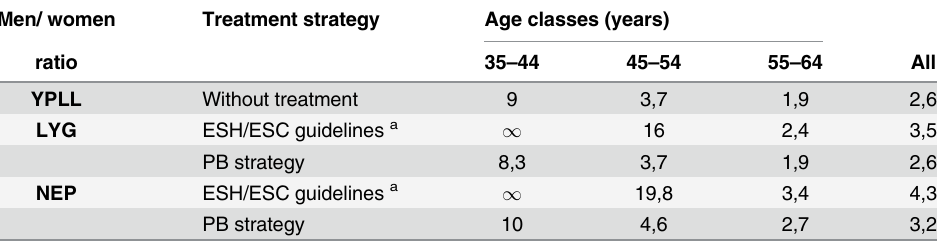
Table 3. Gender-related ratios of potential life lost and gained according to the treatment strategy